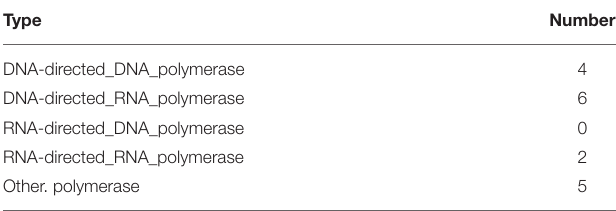
TABLE 11 | Polymerase gene number statistics.